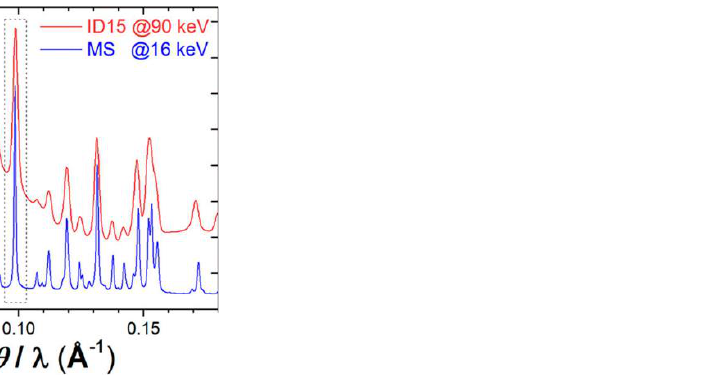
Figure 7. ( a ) 10 mL Perspex grinding vessels stationary and vibrating, ( b ) measured XRD images recorded every 30 s. Reprinted with permission from [55]. Copyright 2014, John Wiley and Sons.